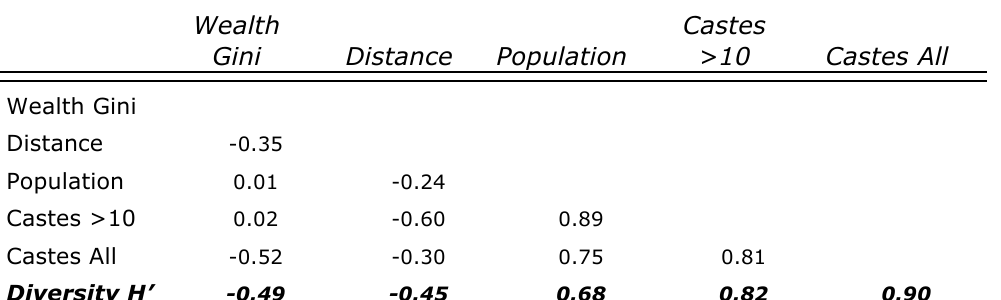
Table A 6. Village-level predictor variable correlations. Population and caste numbers are highly correlated. This is an inescapable feature of population structure in the study region. Larger villages are not necessarily more diverse, but more diverse villages are always larger. Diversity H’ represents the Shannon index calculated for caste diversity, included here for reference.